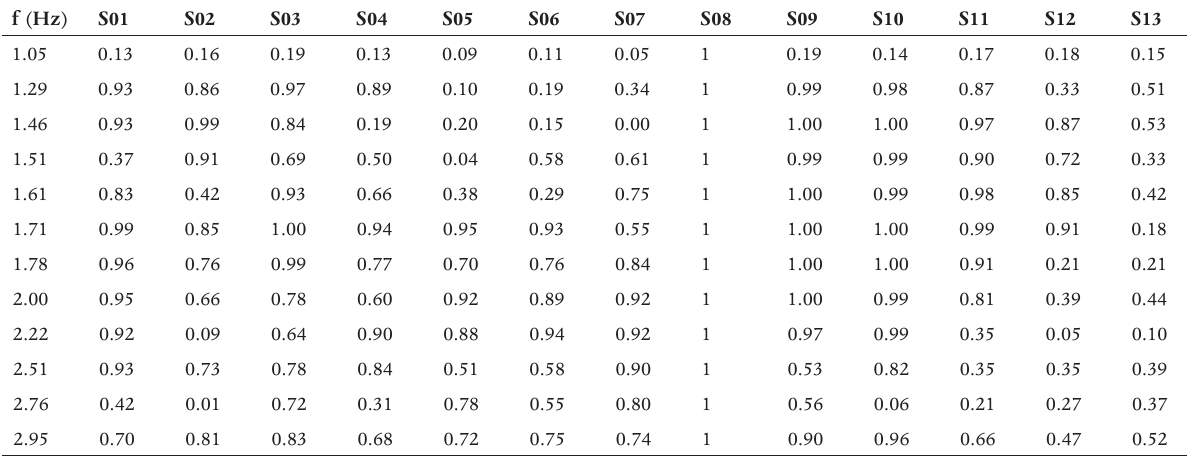
Table 2. Phase factor (°) in C1 with reference to S08.